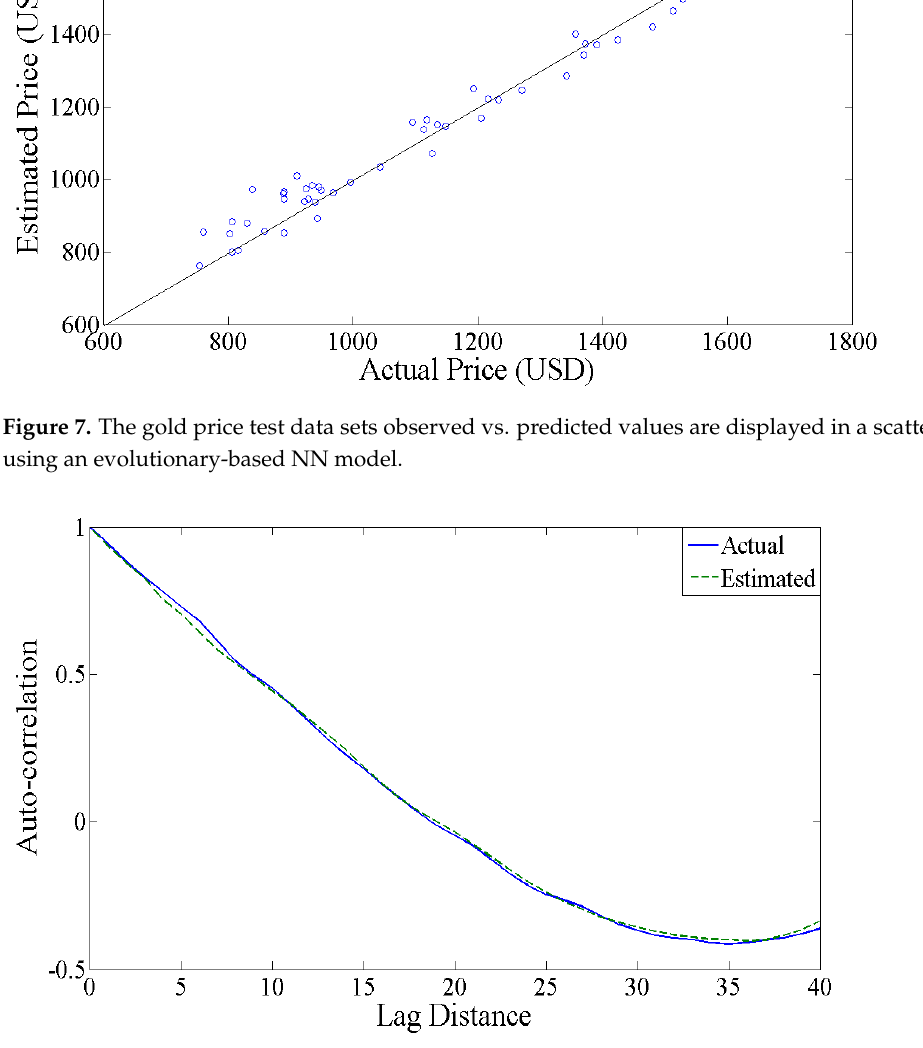
Figure 8. Actual and projected gold price auto-correlation charts for the training data set. Table 3. Forecasting error statistics with our suggested approach and various other neural network architectures, the AR model, and the SVM